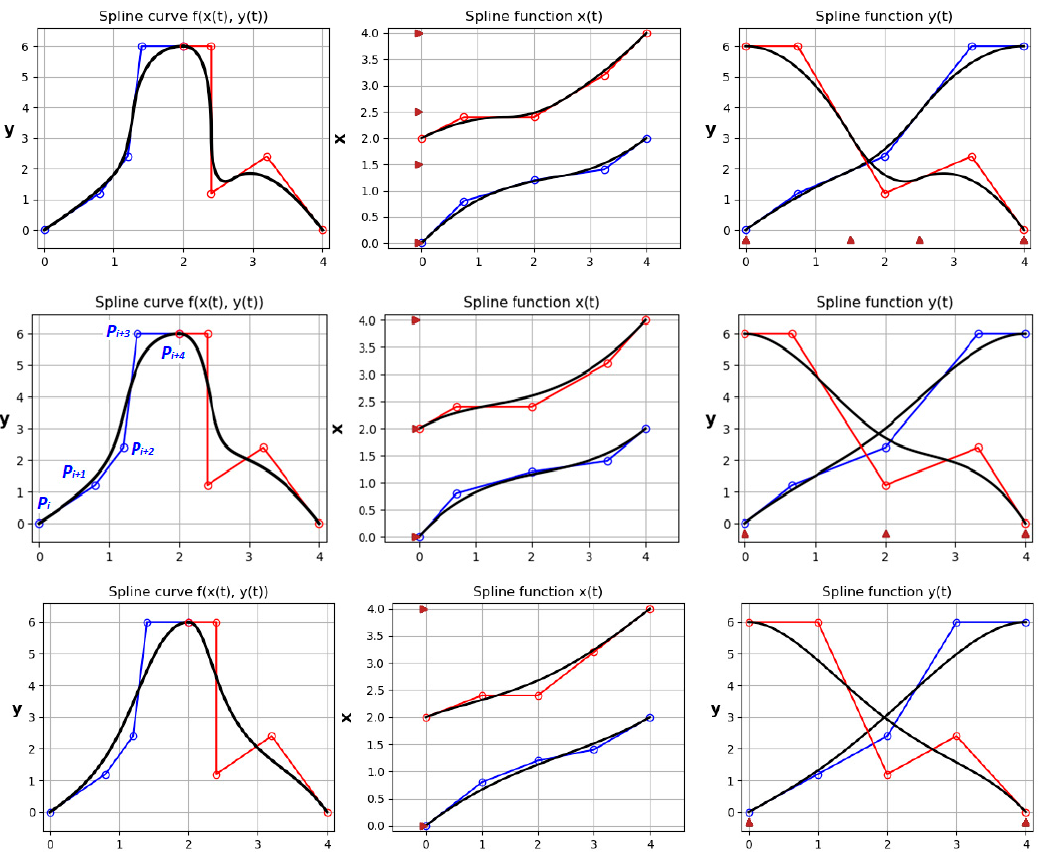
Figure 5. Parametric B ‐ splines of degrees 2 to 4 row wise. All are C2 parametrically